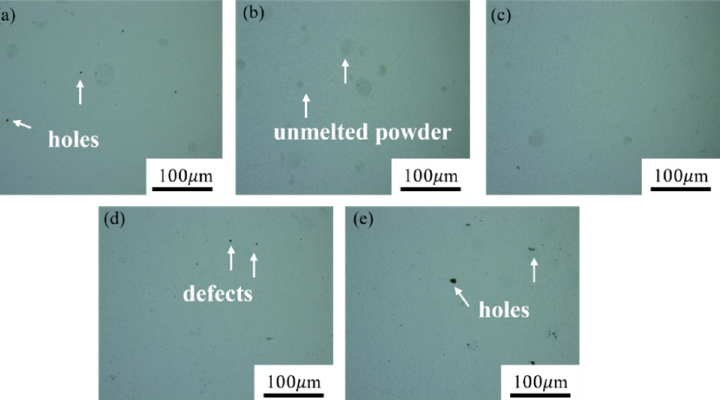
Figure 6. OM micro-structure of LMD-formed CoCrMoNbTi0.4 RHEA before etching at various processing parameters. ( a ) E l = 2.8 J/mm, ( b ) E l = 3.2 J/mm, ( c ) E l = 3.6 J/mm, ( d ) E l = 4.0 J/mm, ( e ) E l = 4.4 J/mm.